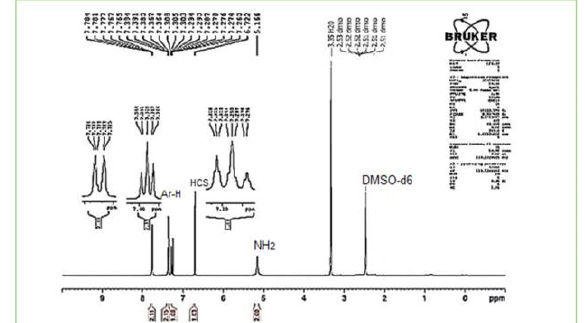
Fig. 3. 1 H NMR of spectrum of 2-Amino 4-(phenyl)thiazole ligand